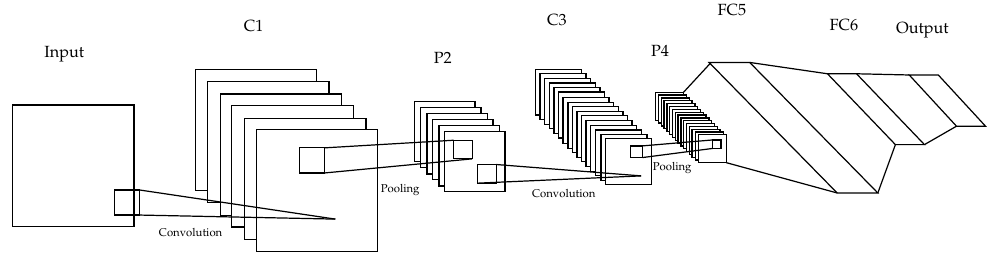
Figure 6. The CNN architecture used for the